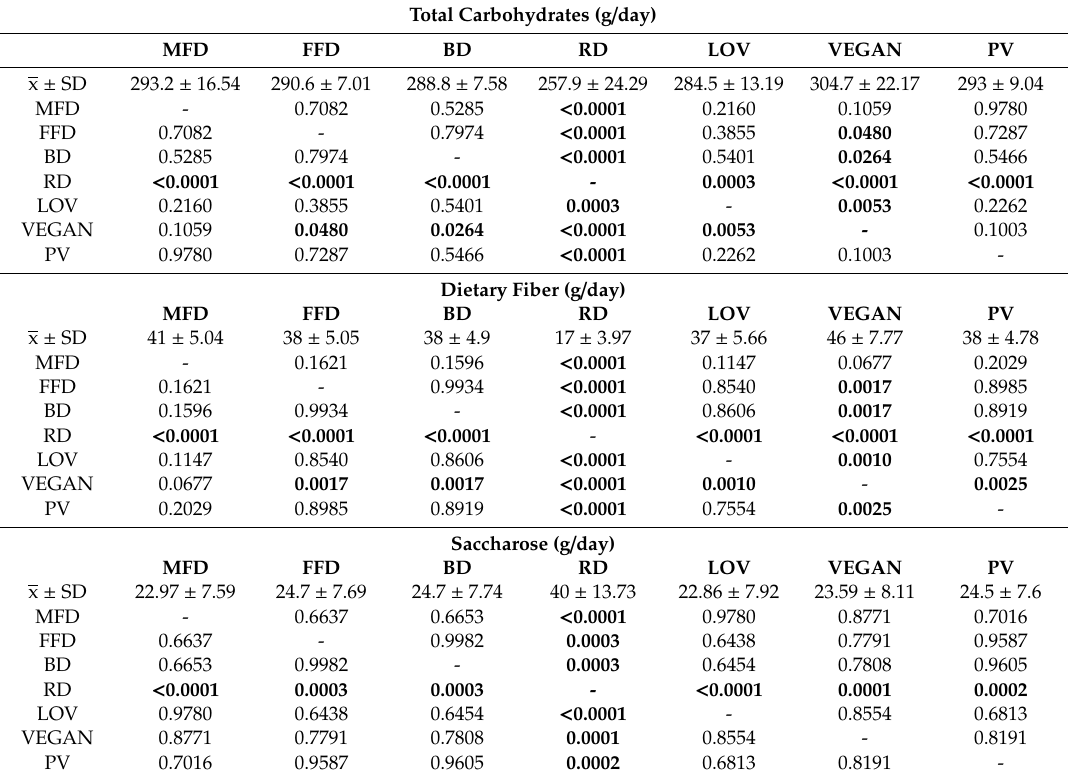
Table 6. The comparison of the average content of carbohydrates, dietary fiber, saccharose, lactose, and starch between the diets (g /